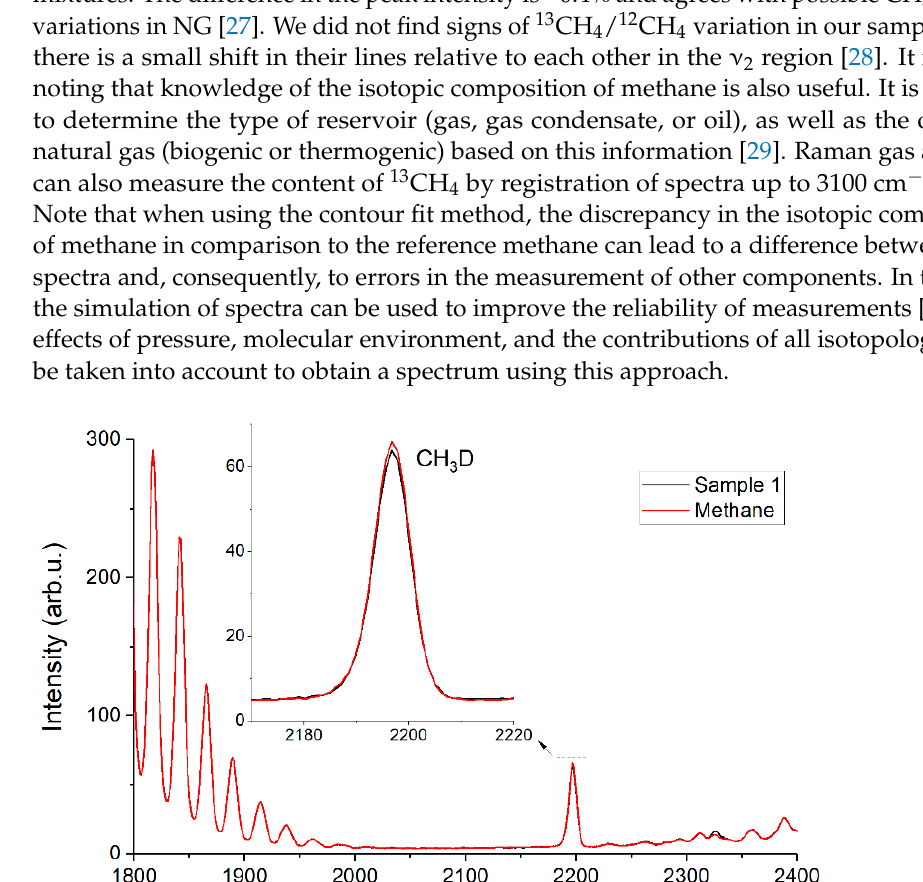
Figure 10. Raman spectra of pure methane and sample 1 in the range of 1800–2400 cm –1 .